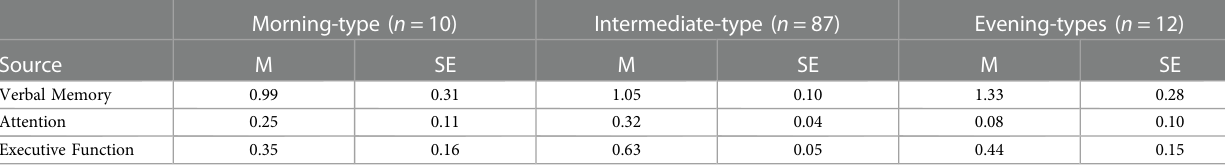
MANCOVA model run with sleep disorders excluded. Model predicts verbal memory, attention, and executive function factor scores from chronotype, controlling for covariates (age, sex, education, BMI, discrepancy between sleep midpoint and time of cognitive testing, and VM CPM). VM CPM, vector magnitude counts per minute; BMI, body mass